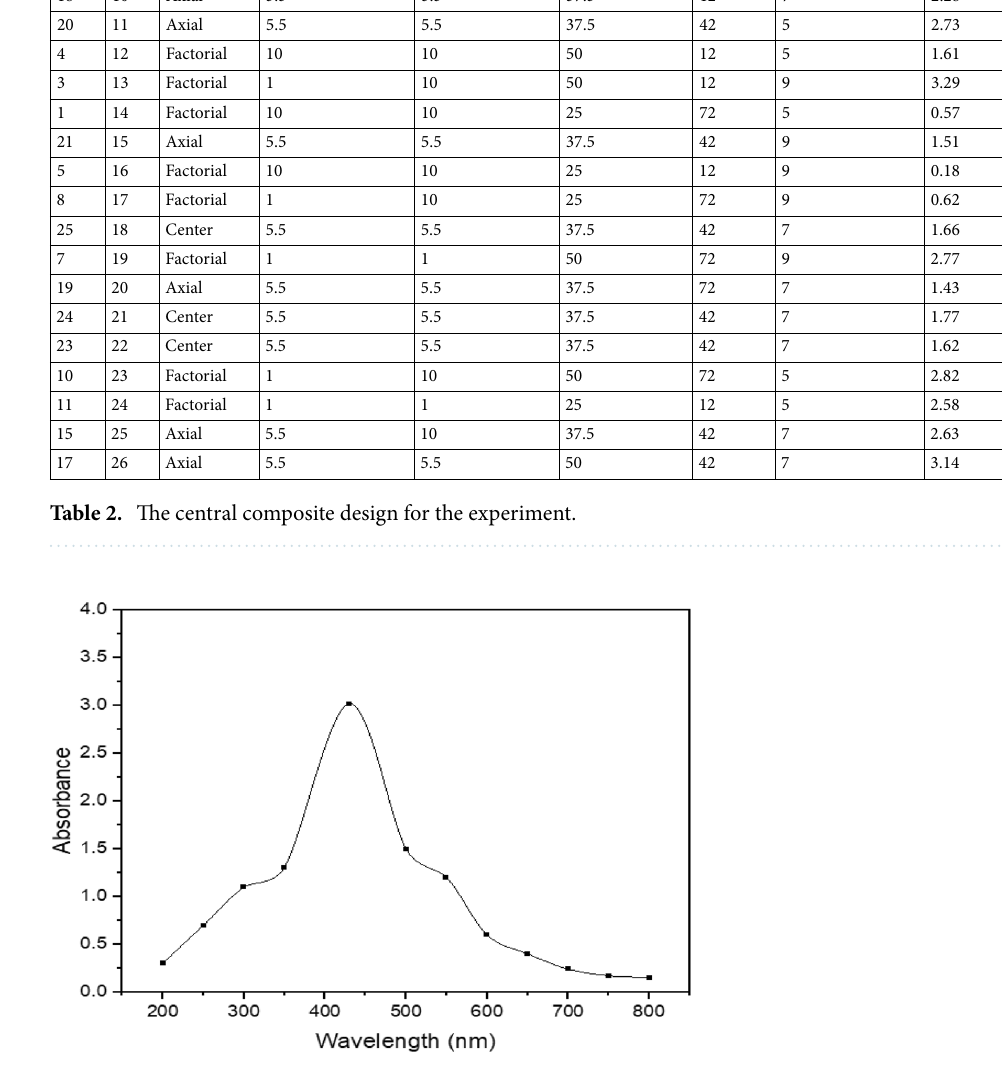
Figure 2. The UV–visible spectrum of biosynthesized silver nanoparticles by using Bacillus